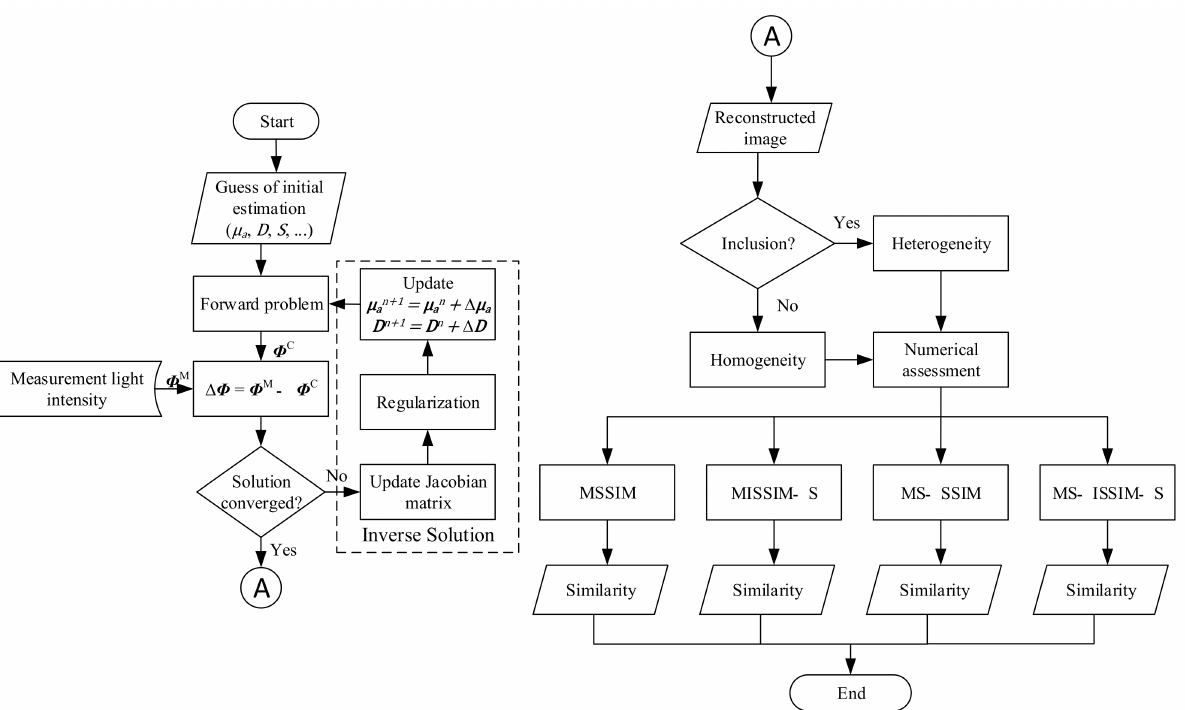
Figure 1. Block diagram of the process used to obtain similarity, where µ a and D are absorption and diffusion coefficients, respectively, S denotes the light source, Φ M expresses measured photon propagation, and Φ C is computed light from solving